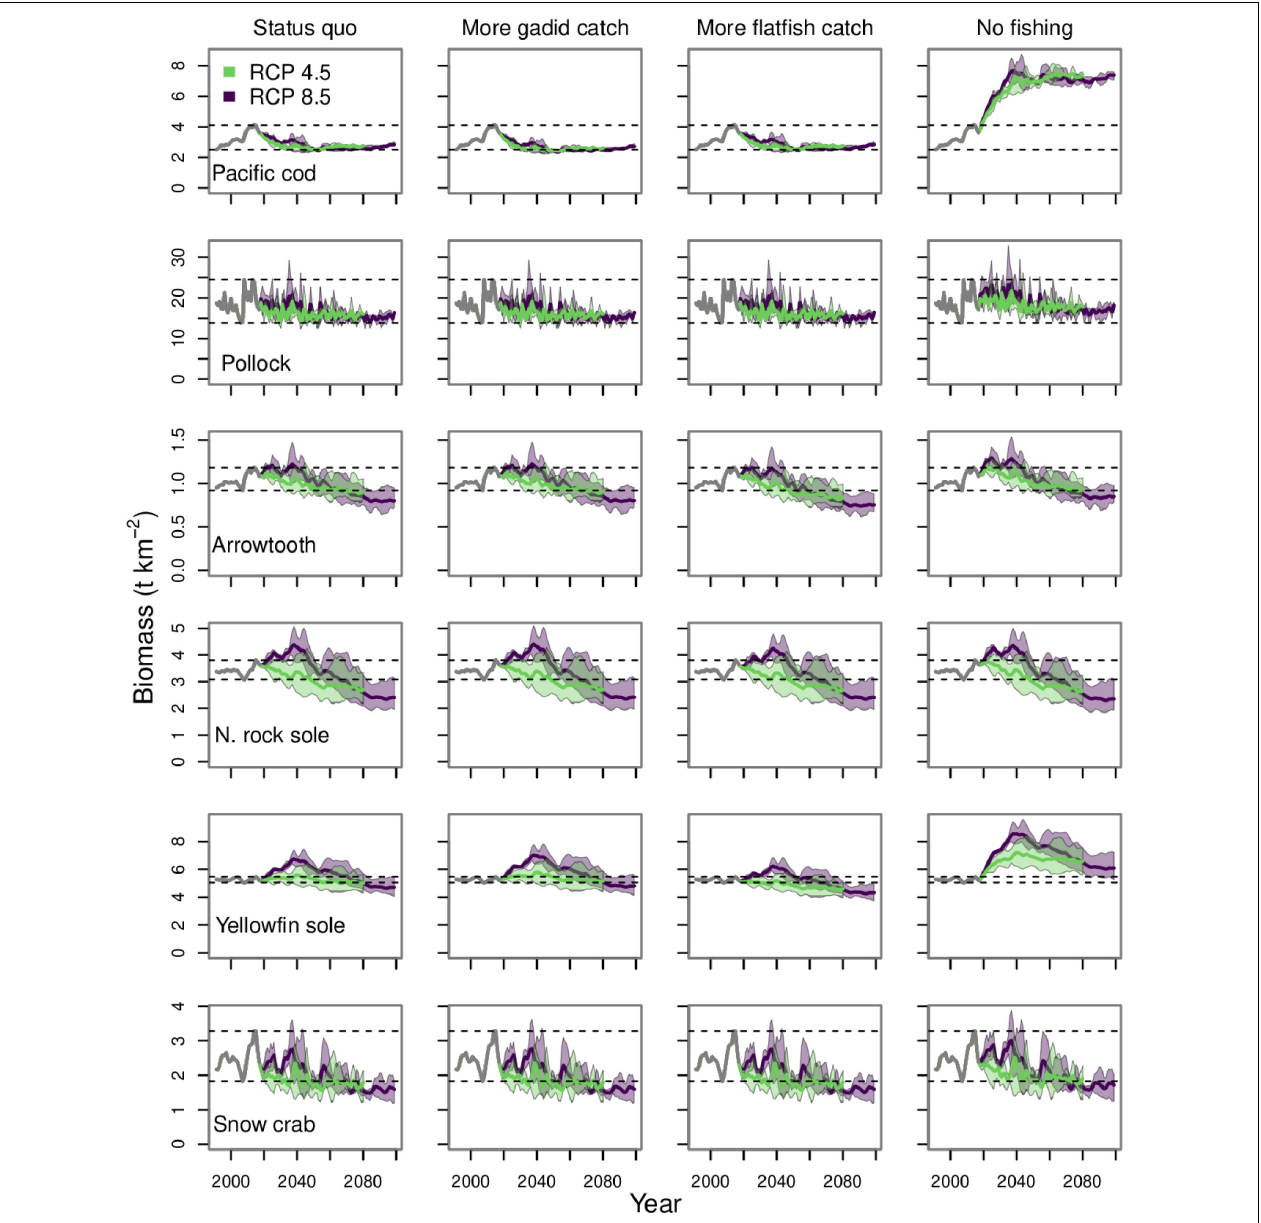
FIGURE 5 | Biomass projections for the core commercial species run under all four fishing scenarios. The gray lines from 1991 to 2017 indicates the historical period. The purple and green polygons indicate the minimum and maximum range for the three earth system models run under each RCP. The purple and green lines indicate the mean of the three runs for each RCP. The dashed lines indicate the minimum and maximum values from the historical